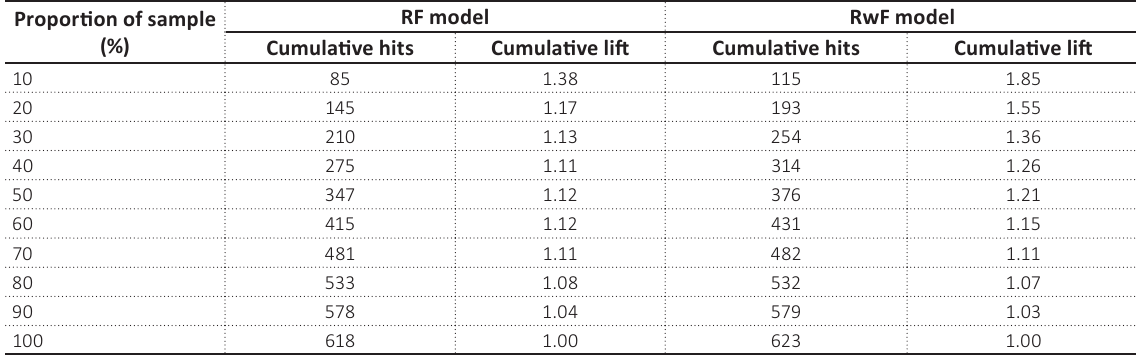
Table 4. Performance results of the models Proportion of sample